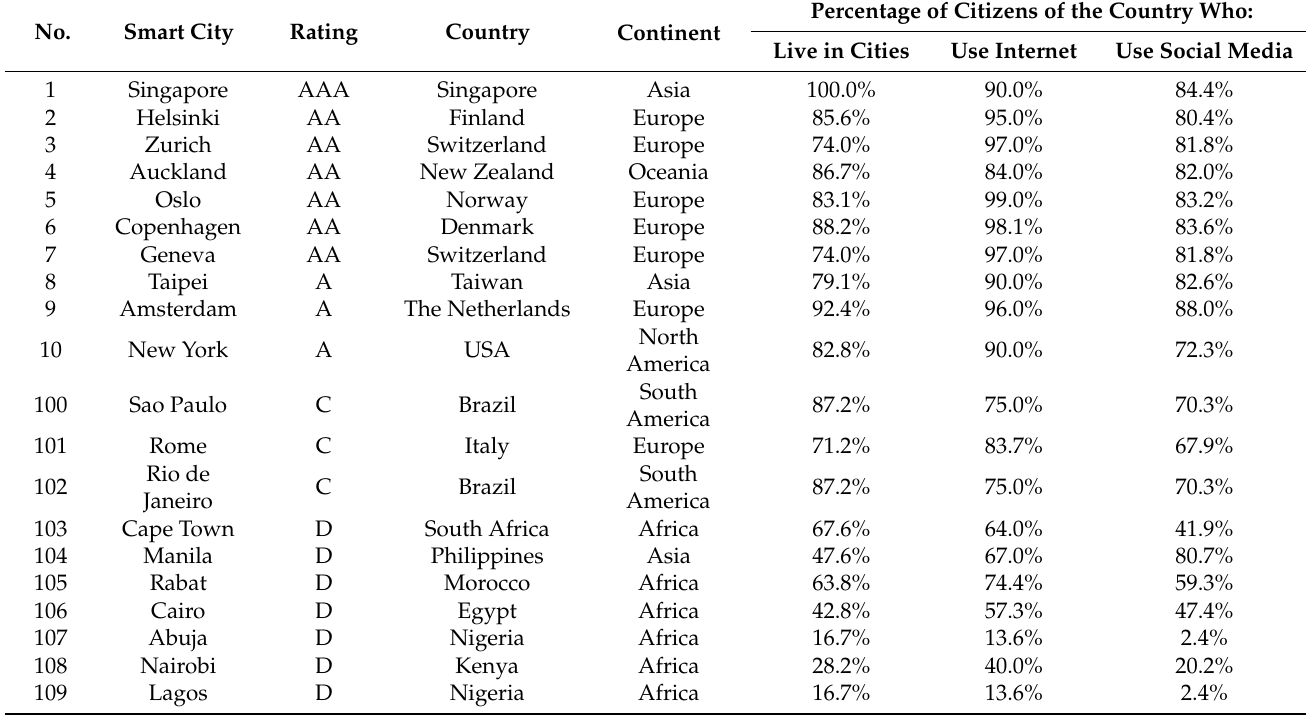
Table 3. The importance of the Internet and social networks in countries with smart cities.